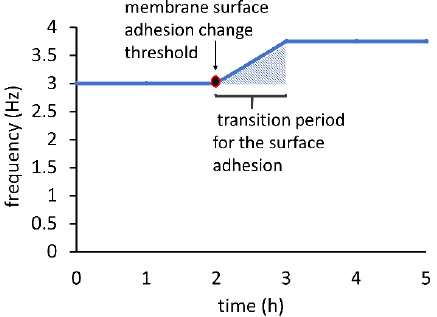
Figure 4. Stability of frequency with time for an oscillator operated with the vacuum supply set to 8 psi.